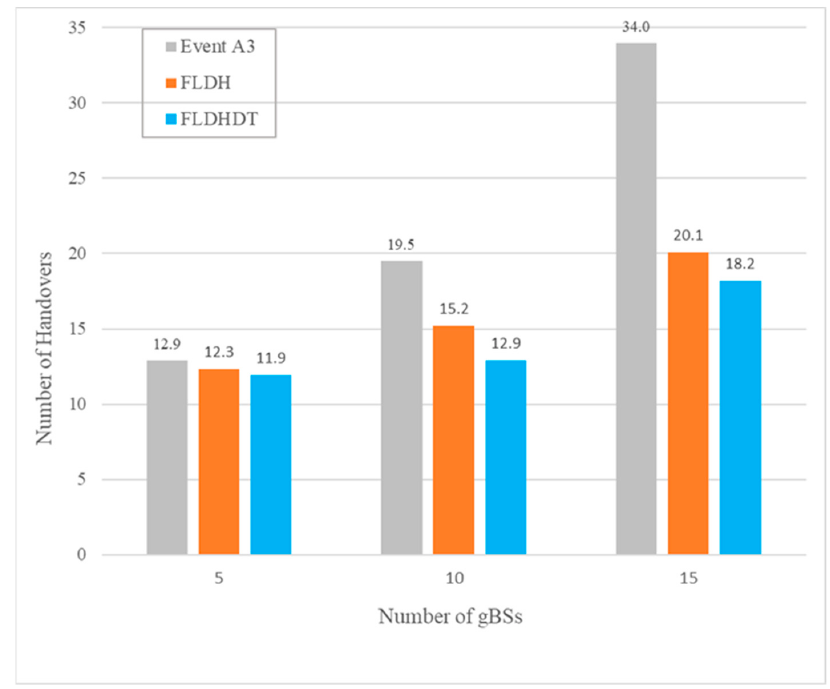
Figure 11. Number of handovers versus number of gNBs.